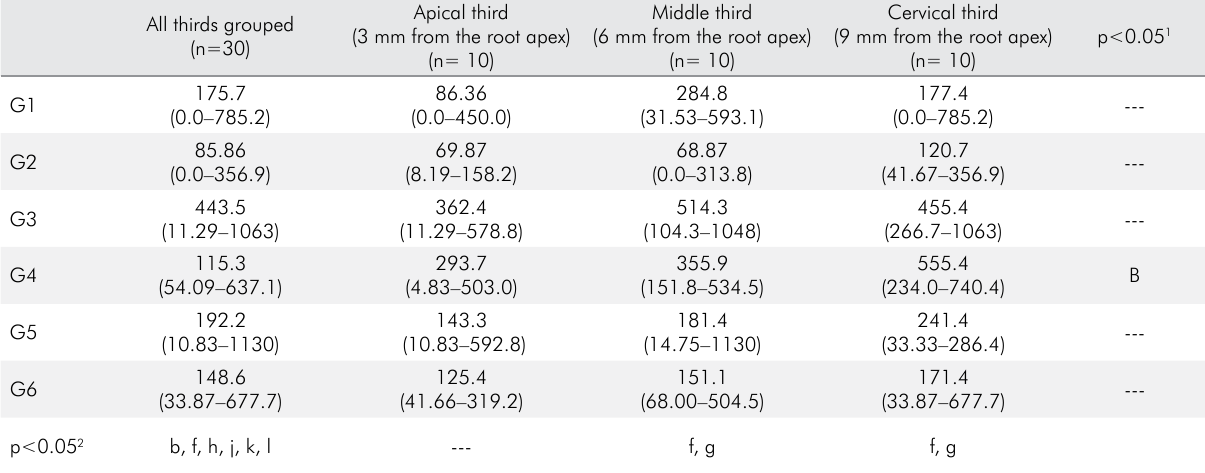
Table 2. Cement penetration assessed by linear measurements (median, minimum, maximum, and comparisons) All thirds grouped